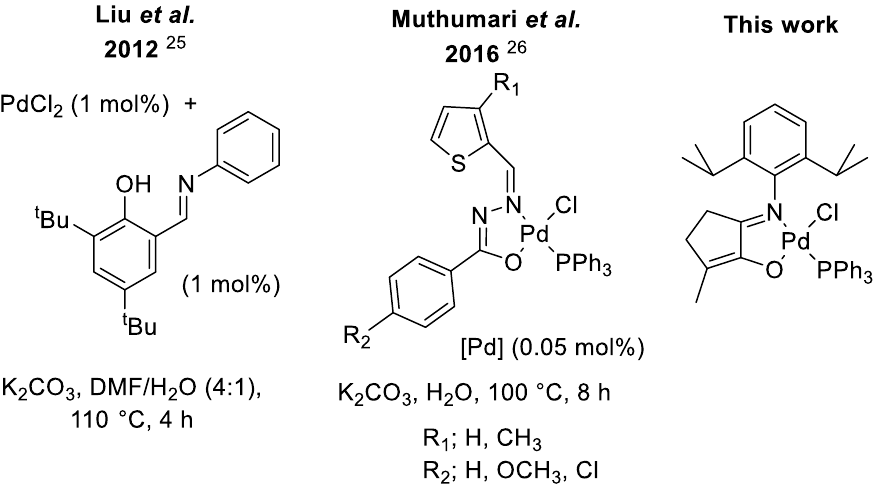
Figure 1. Selected [N,O] catalysts capable of Suzuki-Miyaura cross-coupling reactions [25,26].